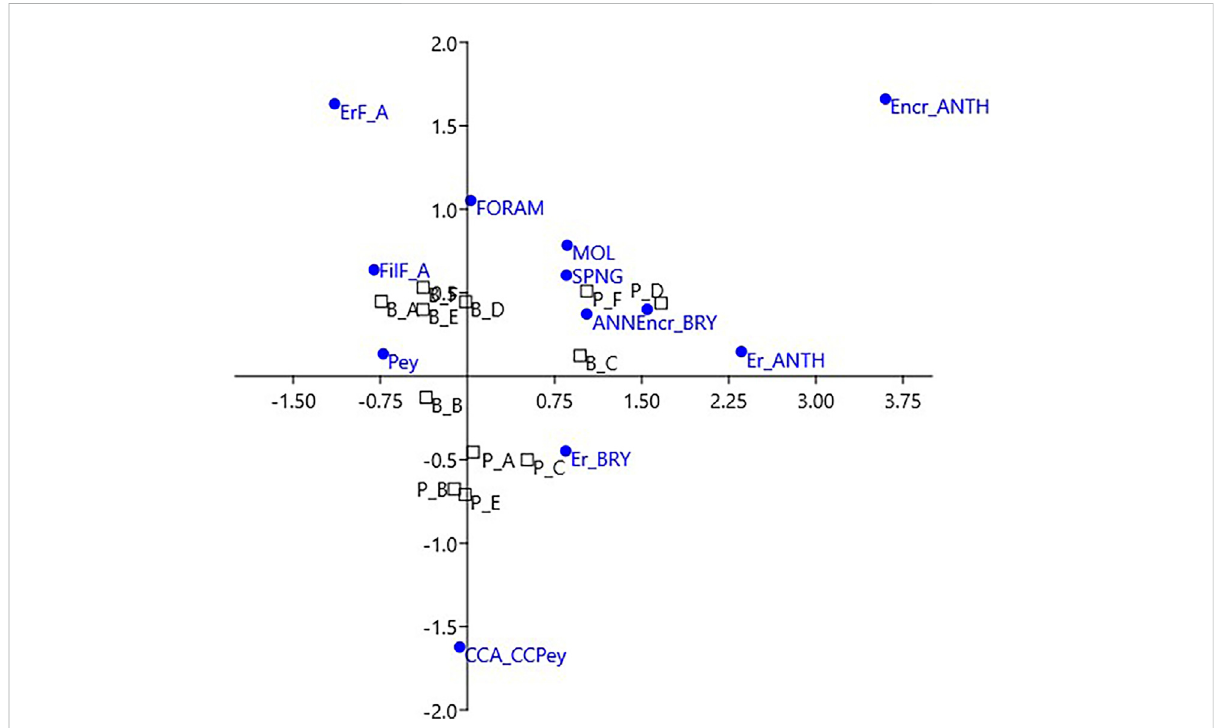
FIGURE 6 Correspondence analysis for the coverage data of the two build-ups. Labels of sides as in Figure 5. Labels of categories as in Tables 1,